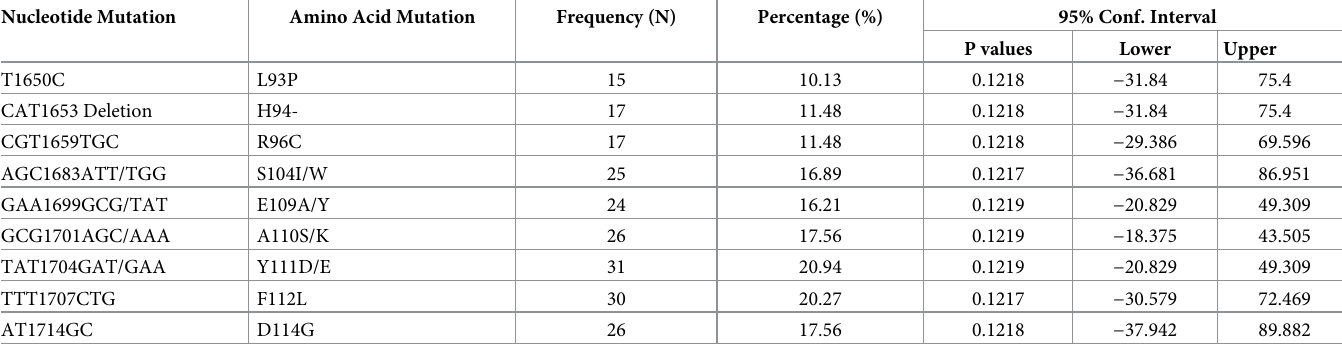
Table 4. Non-reported mutations.